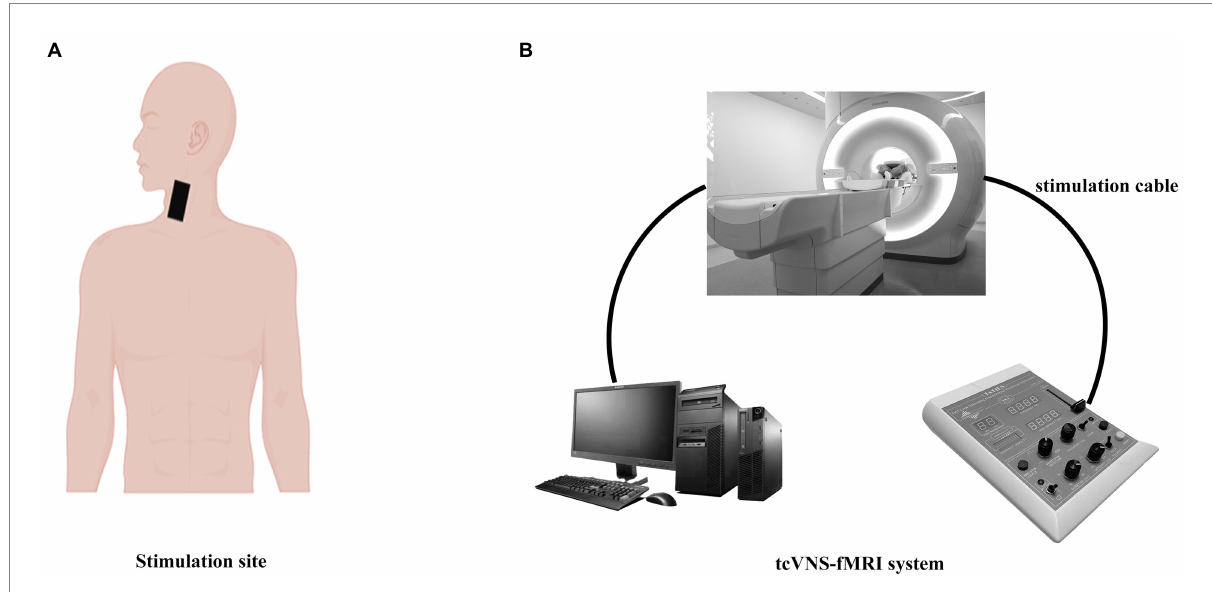
FIGURE 2 Transcutaneous cervical vagus nerve stimulation (tcVNS) with concurrent